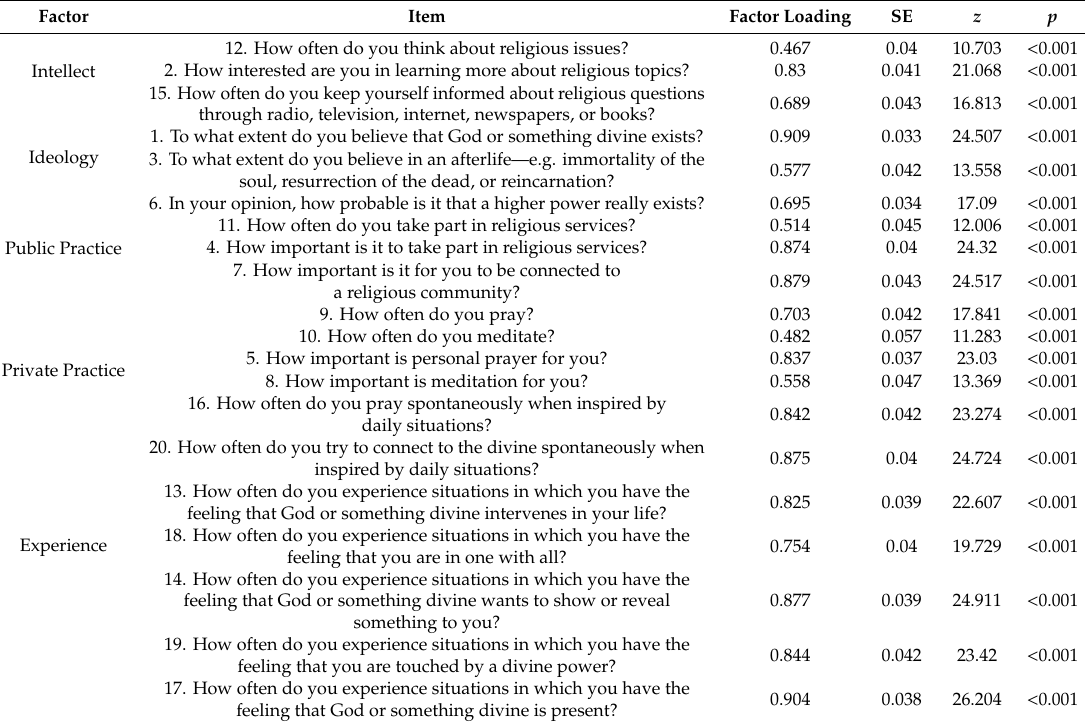
Table 5. Factor Loadings in Model 6, Five-Factor CRSi-20.